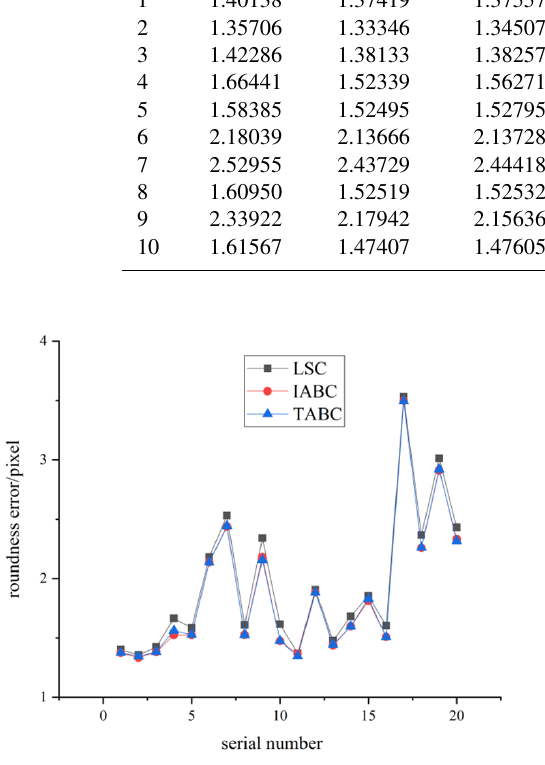
Figure 8. Comparison of the error evaluation results with the least square method.